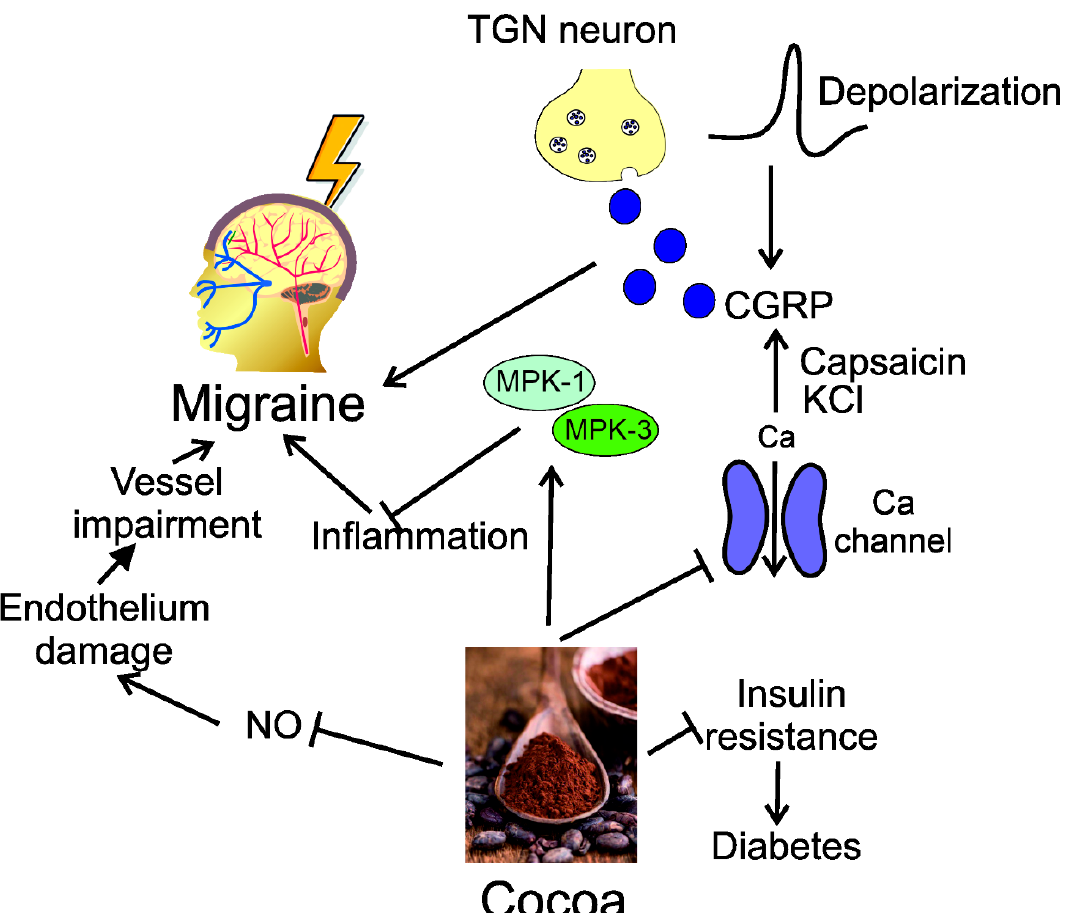
Figure 2. Cocoa is an example of a natural dietary nutrient that may exert beneficial effects against migraine, which may be partly underlined by its interaction with calcitonin-related gene peptide (CGRP) and represents mechanisms that may underline the action of other dietary nutrients on migraine and the CGRP systems. CGRP may be released after the depolarization of trigeminal nerve (TGN) neurons with the involvement of calcium signaling. Cocoa may disrupt calcium channels resulting in changing CGRP release, mediated by capsaicin and KCl. Cocoa may directly inhibit NO production, decreasing vessel impairment underlined by NO-induced endothelial damage. Coca may upregulate mitogen-activated kinase phosphatase-1 (MKP-1) and -3, which exert an anti-inflammatory effect, which is important in migraine prevention. Cocoa is also reported to break insulin resistance preventing diabetes, whose connection with migraine is discussed further in the main